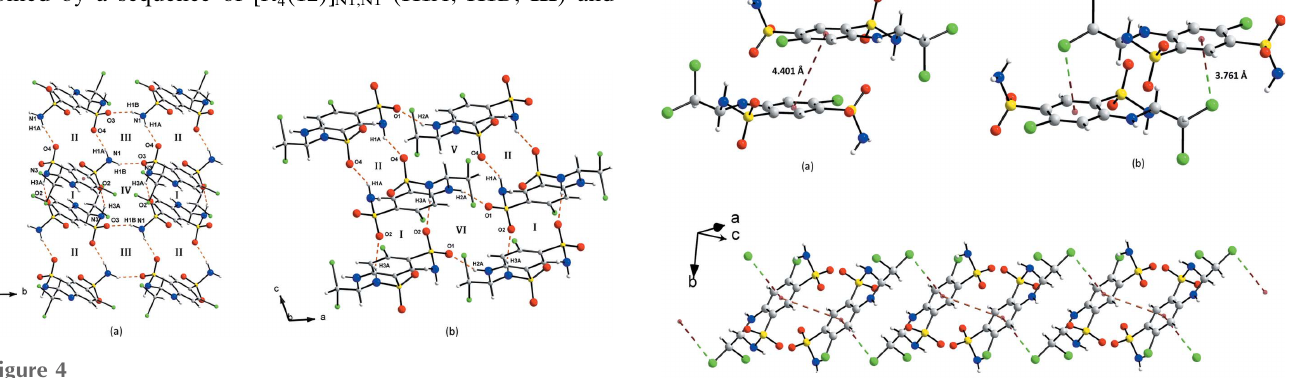
Figure 4 ( a ) Graph-set analysis of the intermolecular N—H (cid:2)(cid:2)(cid:2) O hydrogen bonds Figure 5 in RS -TCMZ projected onto the bc plane. ( b ) Sequence of hydrogen- bond motifs viewed down the b axis. The hydrogen-bonded motifs are Geometry of ( a ) (cid:3) – (cid:3) and ( b ) C—Cl (cid:2)(cid:2)(cid:2) (cid:3) interactions in RS -TCMZ; ( c ) labelled as I : [ R 2 sequence of head-to-tail (cid:3) – (cid:3) connected dimers and head-to-tail C— (16)] O2 N3 ; II : [ R 2 (16)] O4 N1 ; III : [ R 4 (12)] O3,O4 N1,N1 ; IV : 2 2 4 Cl (cid:2)(cid:2)(cid:2) (cid:3) connected dimers in RS -TCMZ. [ R 4 (16)] O2,O3 N1,N3 ; V : [ R 4 (20)] O1,O4 N2,N1 ; VI : [ R 4 (16)] O1,O2 N2,N3 . 4 4 4